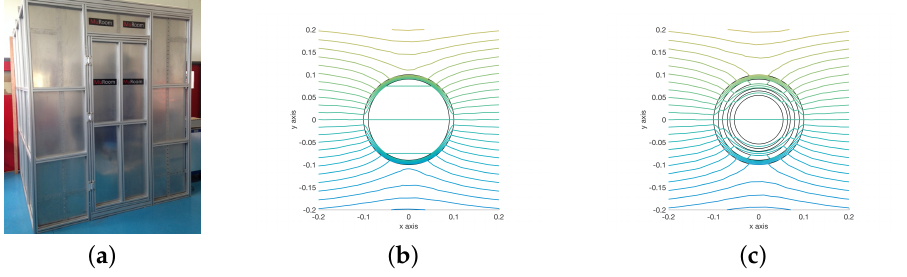
Figure 1. Example of a commercial Magnetically Shielded Room (MSR) ( a ). Qualitative representa- tions of the flux lines in a one-layered and a three-layered cylindrical shield ( b , c ). Bearing all this in mind, it is apparent that the outermost layer is subject to the external magnetic field value, whereas the innermost layer is subject to a very low residual